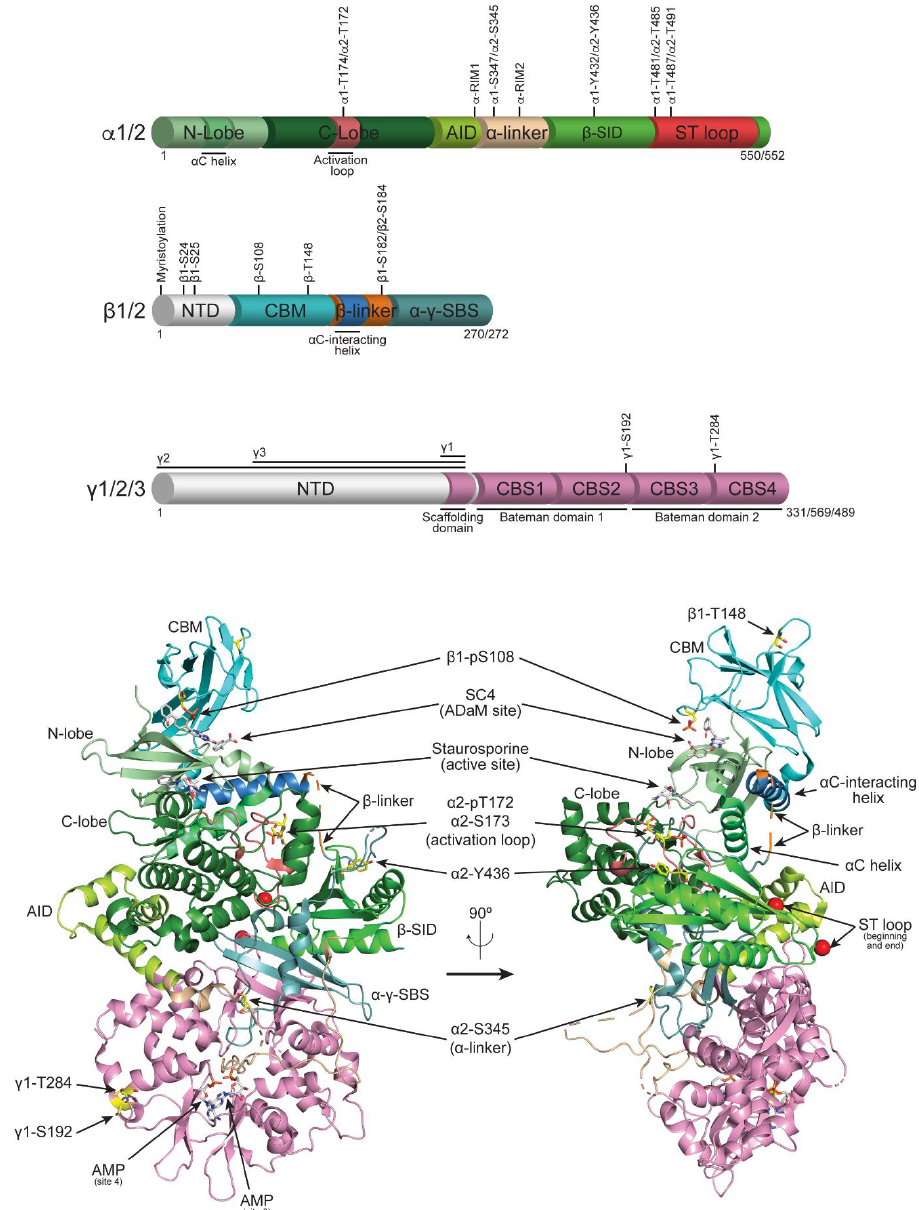
Figure 1. Schematic representation of subunit domain organisation and cartoon representation of the AMPK quater- nary structure. The AMPK heterotrimer consists of a catalytic- regulatory α - subunit (green), and regulatory β - (blue) and γ - (magenta) subunits. The main structural features are shown above as a linear tube representation, with indication to the location of phosphorylation sites with known function. The varying lengths of the γ - subunit NTD’s are depicted above the γ -subunit domain schematic. The crystal structure of the α2β1γ1 in complex with SC4 (PDB: 6B1U) is shown below as a cartoon representation and the subunit features are colour coded to that of the tube schematics above. SC4 (white sticks) is shown bound to the ADaM-site created at the interface of the CBM and the N-lobe of the kinase domain. Staurosporine (white sticks) is shown bound to the active site between the N- and C-lobes of the kinase domain. Two AMP molecules (white sticks) are shown bound to the γ -subunit in sites 3 and 4. Phosphorylated α 2-T172 ( α 2-pT172) and β 1-S108 ( β 1-pS108), and non-phosphorylated α 2-S173, α 2-S345, α 2-Y436, β 1-T148, γ 1-S192 and γ 1-T284 are shown as yellow sticks. The flexible ST loop, β -subunit NTD and β -linker regions that all contain functional phosphorylation sites are not modelled in any current AMPK crystal structures. The beginning and end of the ST loop is shown here as red spheres. The image shown on the right is a 90 ◦ rotation (to the left) of the image on the left; image generated using